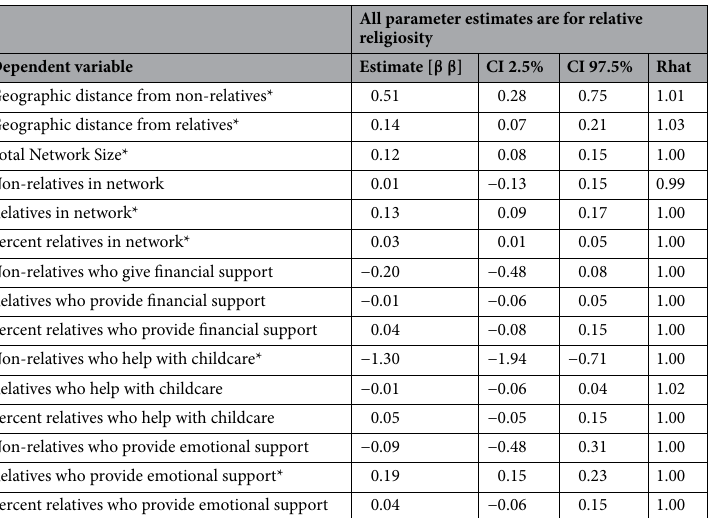
Table 1. Effect of religiosity on multiple dependent variables. Parameter estimate [ β ], 97.5% Bayesian Credibility Intervals (CI) and Rhat values which provides information on the convergence of the Markov chains with values near 1 suggesting good mixing (cf., Gelman and Rubin, 1992). CI estimates that do not overlap with 0 have been marked with an asterisk although we recognize that there is nothing special about this designation. *Result s controlled for the age of the respondent, three indices of market integration (see Methods: market integration), sex, religion, religious knowledge and the number of children in the